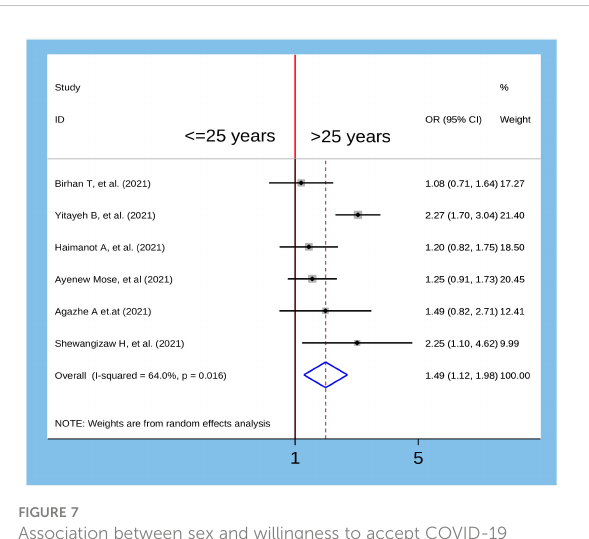
FIGURE 6 Sensitivity analysis of willingness to accept COVID-19 vaccine in Ethiopia, 2022.